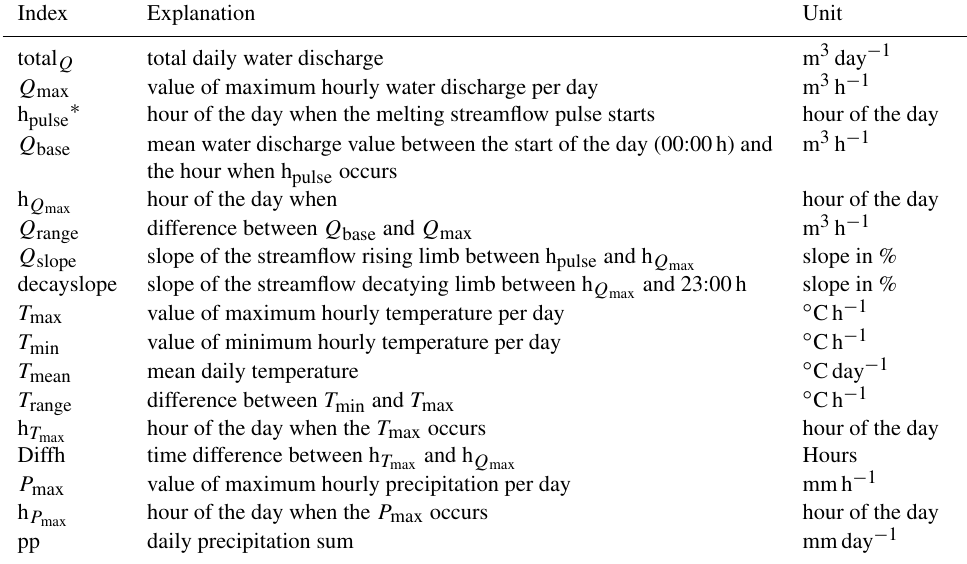
Table 1. Hydrologic and climatic indices computed from the hourly streamflow, temperature and precipitation series. ∗ h pulse is computed as the hourly equivalent of the melting–runoff spring pulse proposed by Cayan et al. (2001) for daily data, i.e., the time of the day when the minimum cumulative streamflow anomaly occurs, which is equivalent to finding the hour after which most flows are greater than the daily